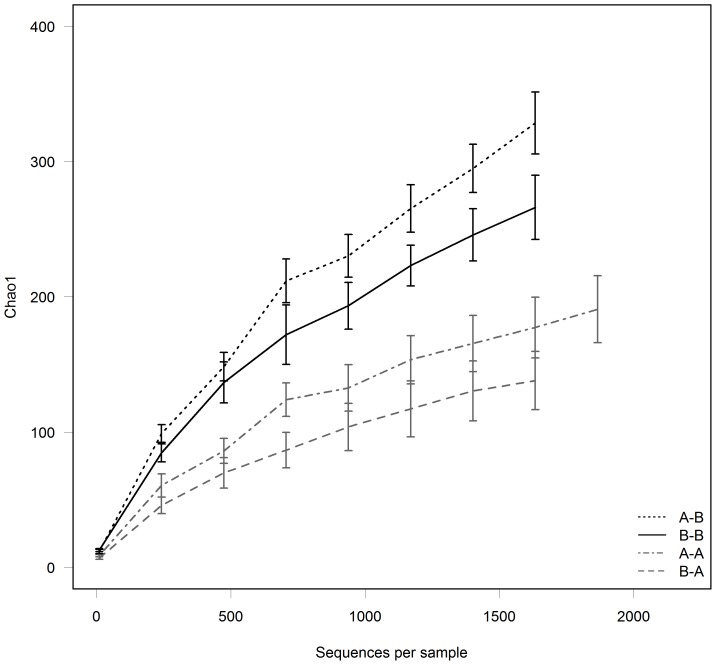
The effects of pre- and post-weaning feeding of Diet A or Diet B on faecal microbial diversity in kittens (Felis catus).The rarefaction curves based on the Chao1 diversity index (at 97% sequence identity cut-off) indicate that faecal bacterial communities of kittens fed Diet B (A-B and B-B; n = 10) were more diverse than those fed Diet A (A-A and B-A, n = 10). Pre-weaning diet did not have an effect on community diversity in the kitten. Data are reported as means ± SEM.